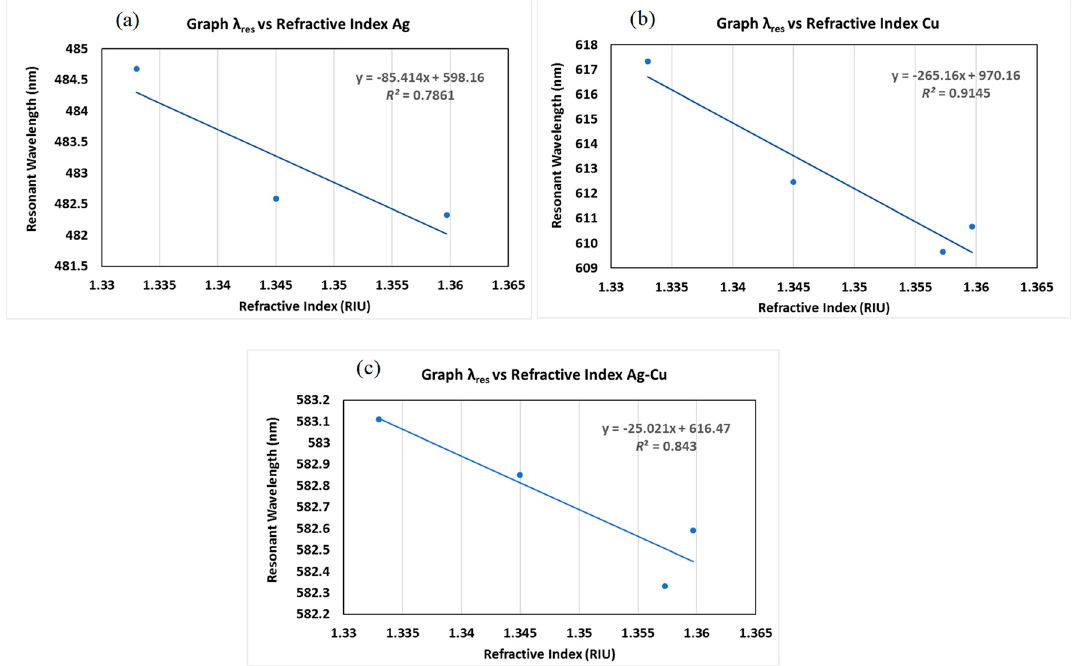
Figure 9. Graph of resonance wavelength against the refractive index for ( a ) Ag, ( b ) Cu, and ( c ) Ag–Cu bimetallic combination.